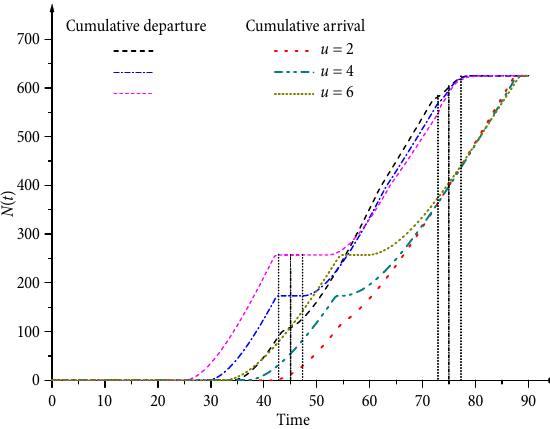
Fig. 7. Cumulative N -curves for the first type of toll profiles